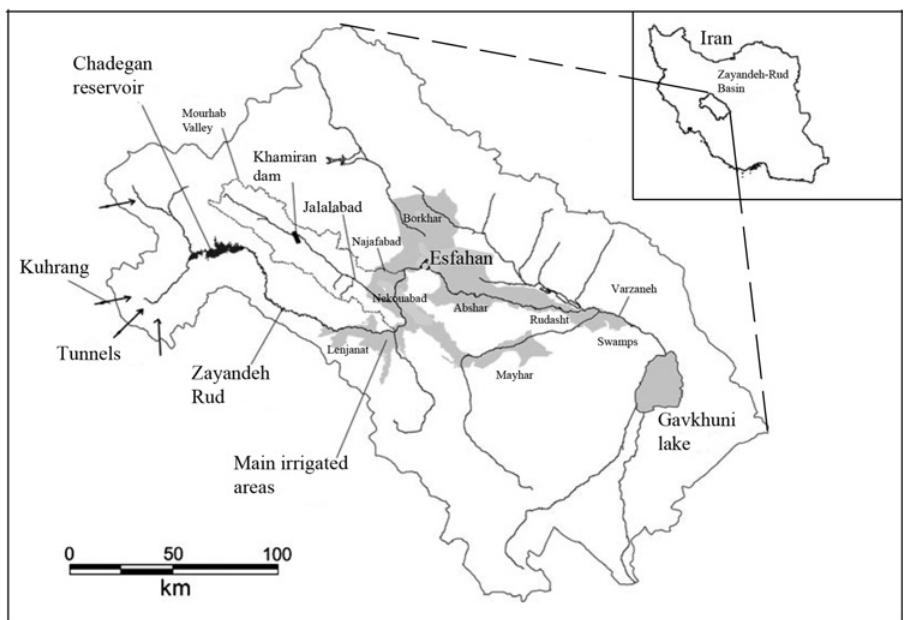
Fig 3. Zayandeh-Rud river basin and reservoir